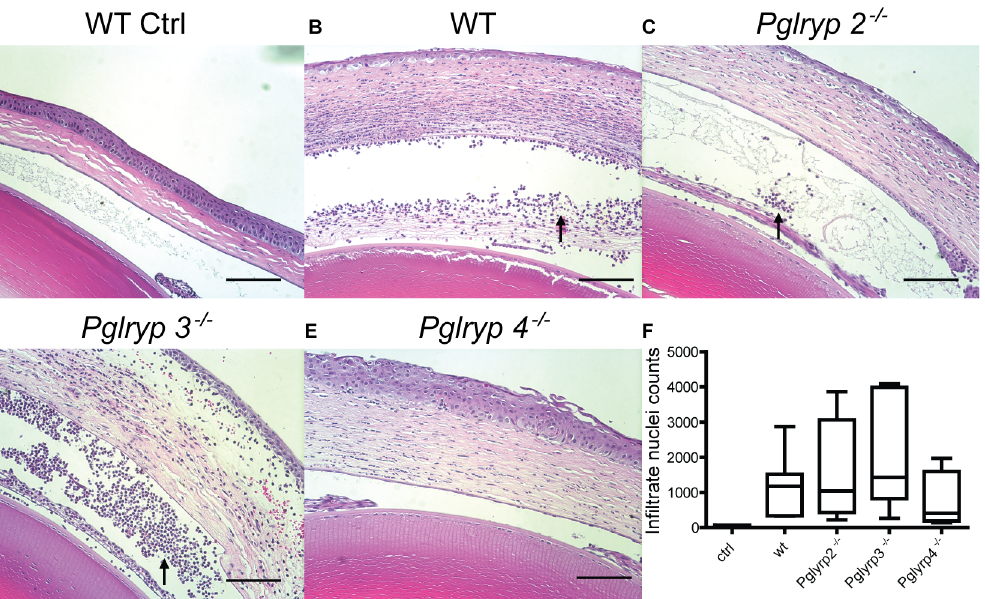
Fig 3. Histology of eyes 48 h.p.i. H and E staining of parasagittal sections through the eye showing the lens (Le), anterior chamber (Ac) and the cornea (Co) (A-E). Cellular inflammatory infiltrates (arrow head) were quantified by counting the nuclei using Image J from 3 – 5 animals per genotype (F) (additional details provided in S2